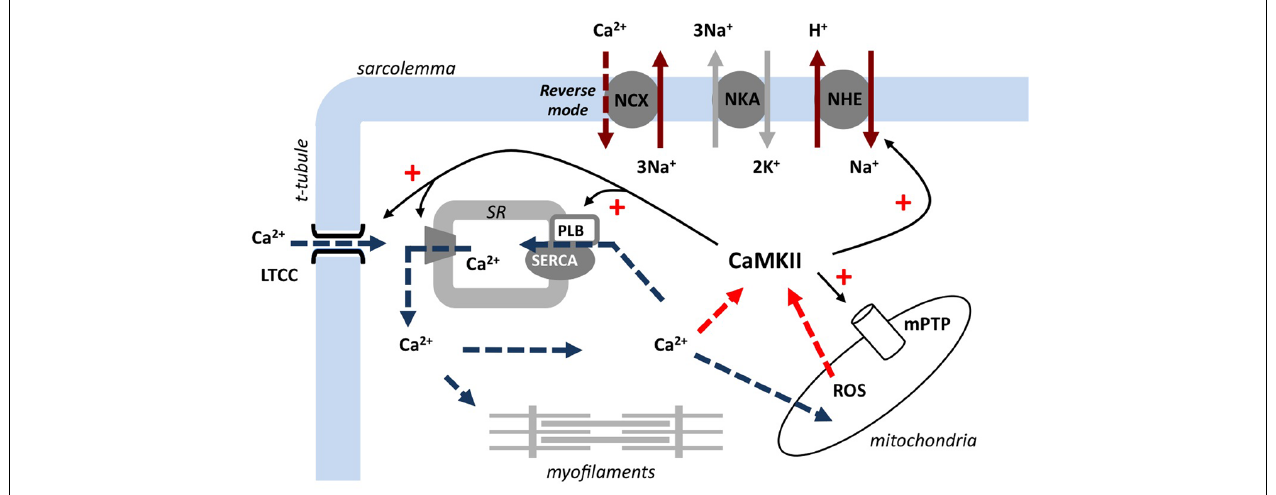
FIGURE 1 | Overview of CaMKII activation and substrate interaction in reperfusion. Post-ischemic restoration of coronary flow re-establishes the trans-sarcolemmal proton gradient and stimulates Na + /H + exchange.This promotes reverse-mode Na + /Ca 2 + exchange and leads to intracellular Ca 2 + overload. Ca 2 + -activated CaMKII upregulates many Ca 2 + -related channels/transporters, further increasing cytosolic/mitochondrial Ca 2 + levels, and triggers the opening of the mitochondrial permeability transition pore.The